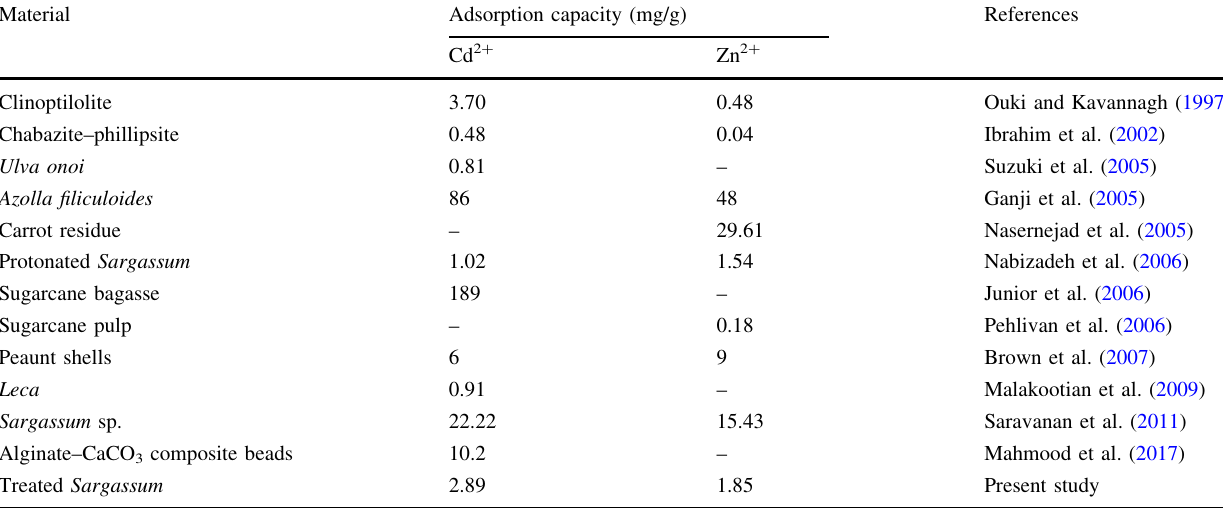
Table 3 Adsorption capacities of Cd 2 ? and Zn 2 ? on various materials reported in